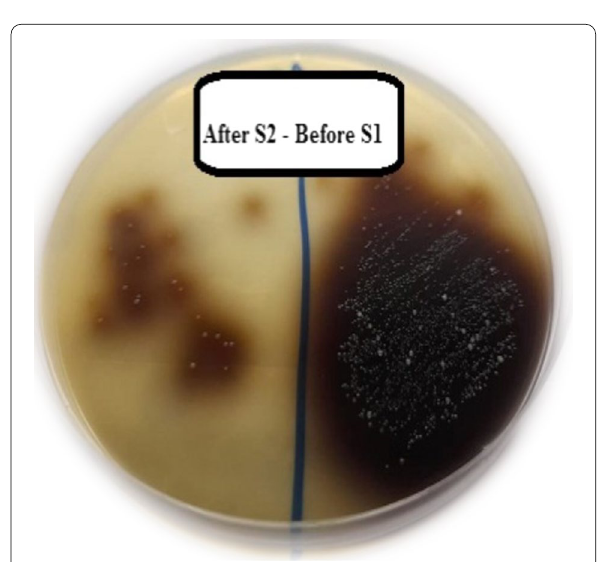
Fig. 6 Culture of S1 and S2 in AgNPs with curcumin paste group